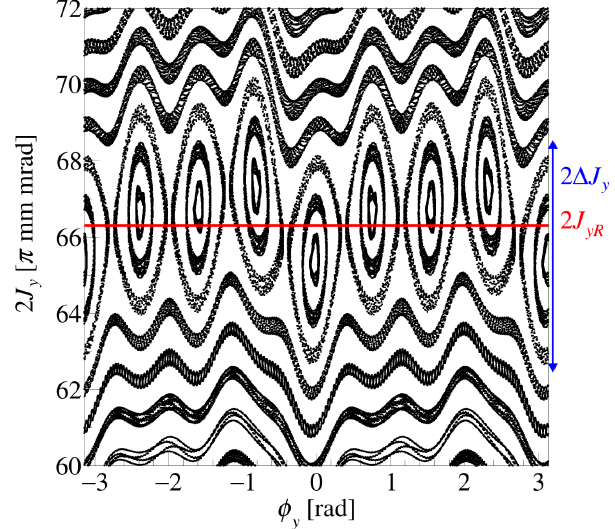
FIG. 6. Simulated Poincar´e map in the vertical plane using the present FX parameters. The horizontal action was set to J x ¼ 0 . The red line plots the analytically solved vertical action of the on-resonance particles 2 J yR .